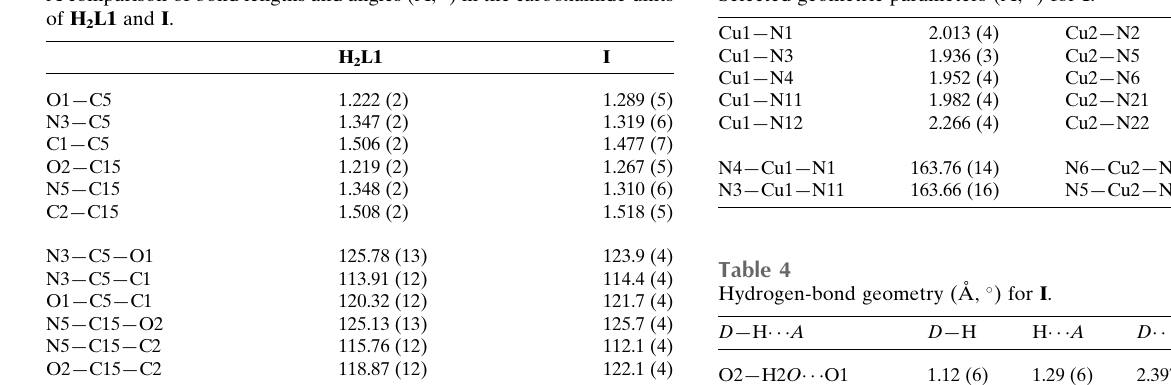
Table 3 Selected geometric parameters (A˚ , (cid:2) ) for I .